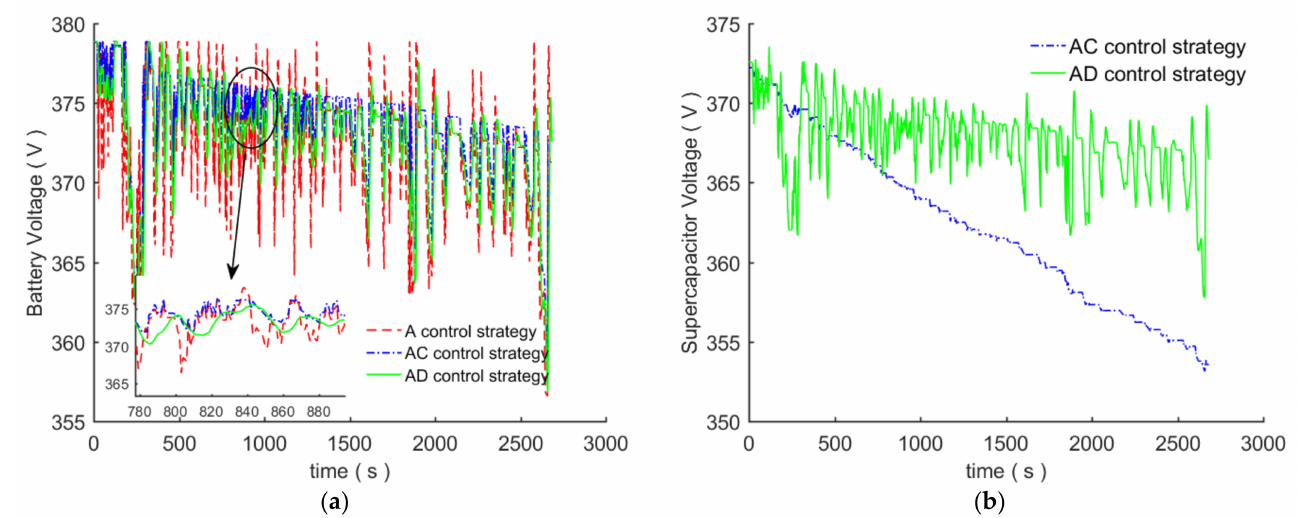
Figure 12. Voltage change diagram of the battery and supercapacitor: ( a ) battery voltage; ( b ) superca- pacitor